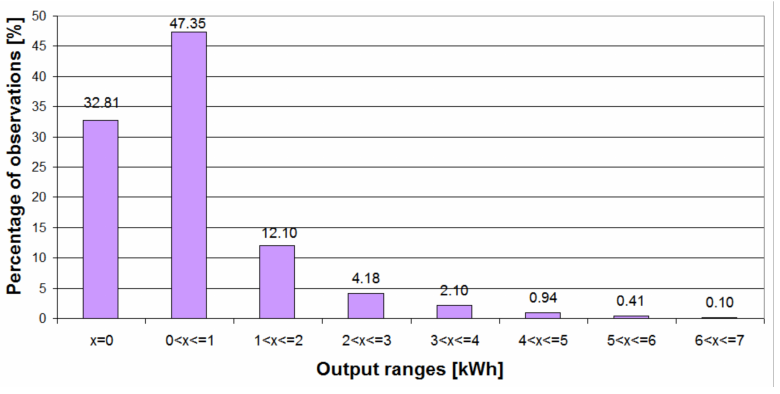
Figure 1. Percentage of time-series observations in particular generation ranges.